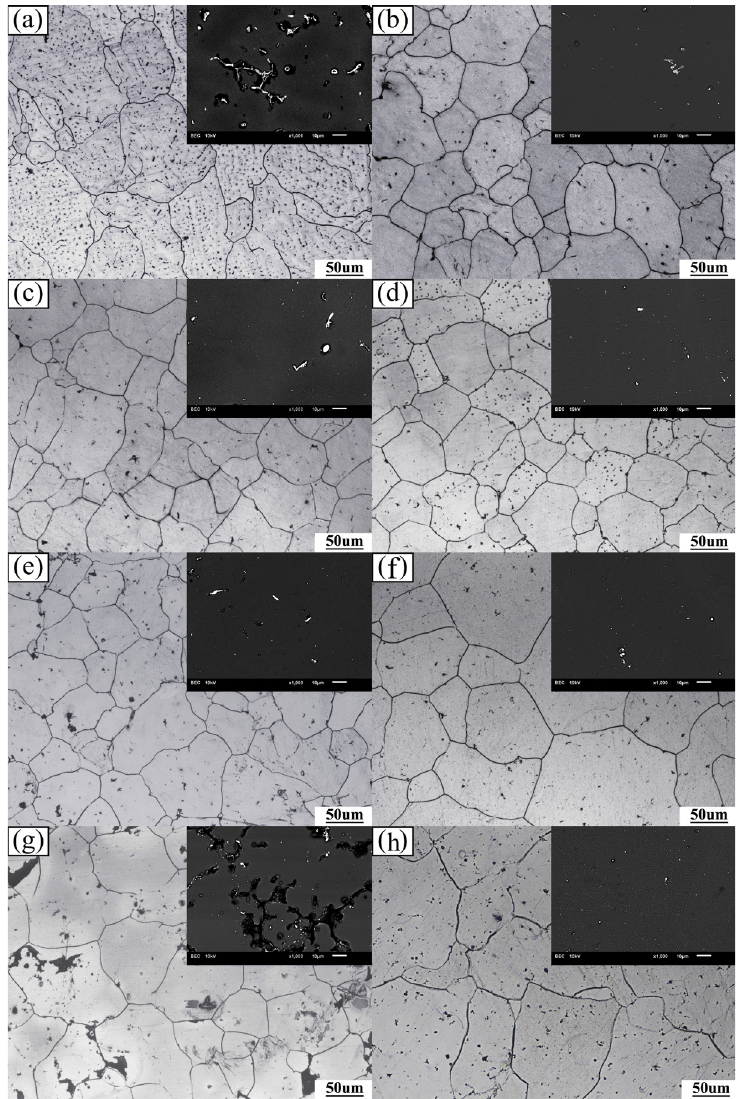
Figure 5. OM and typical SEM images of alloy homogenized for 8 hours at different temperature: (a) 360 ºC, (c) 380 ºC, (e) 400 ºC, (g) 440 ºC and at 380 ºC for various holding time: (b) 4 h, (d) 12 h, (f) 16 h, (h) 24